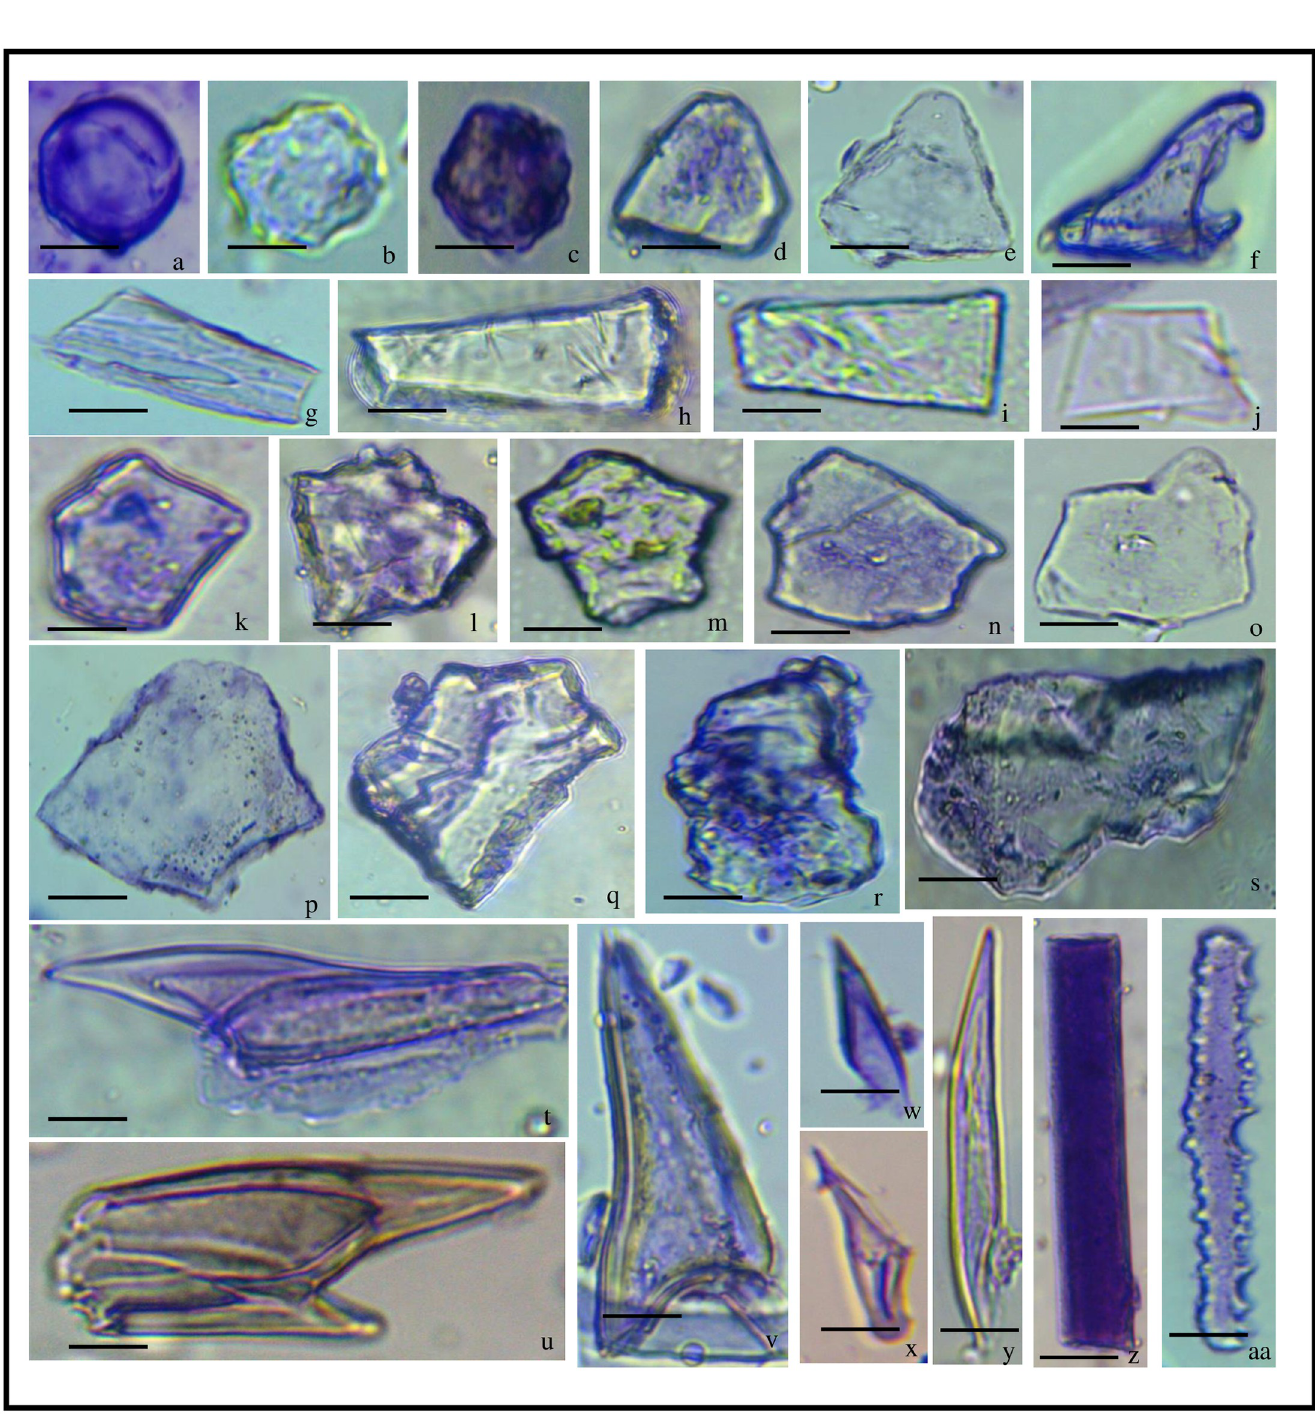
Fig 6. Phytolith morphotypes of Acrachne racemosa (Heyne ex Roem. & Schult.) Ohwi (Synflorescence). Globular psilate (a); Globular granulate (b, c); Triangular (d, e); Cavate (f); Tabular simple (g, h); Long trapezoids (i); Trapezoid (j); Polyhedral (k); Blocky polyhedral (l); Polyhedral (m, n); Tabular polyhedral (o, p); Blocky polyhedral (q); Blocky irregular (r, s); Acute bulbous (t-v) Acute (w, x) Acicular (y); Smooth elongate (z); Elongate echinate (aa): bar = 20 μ m.